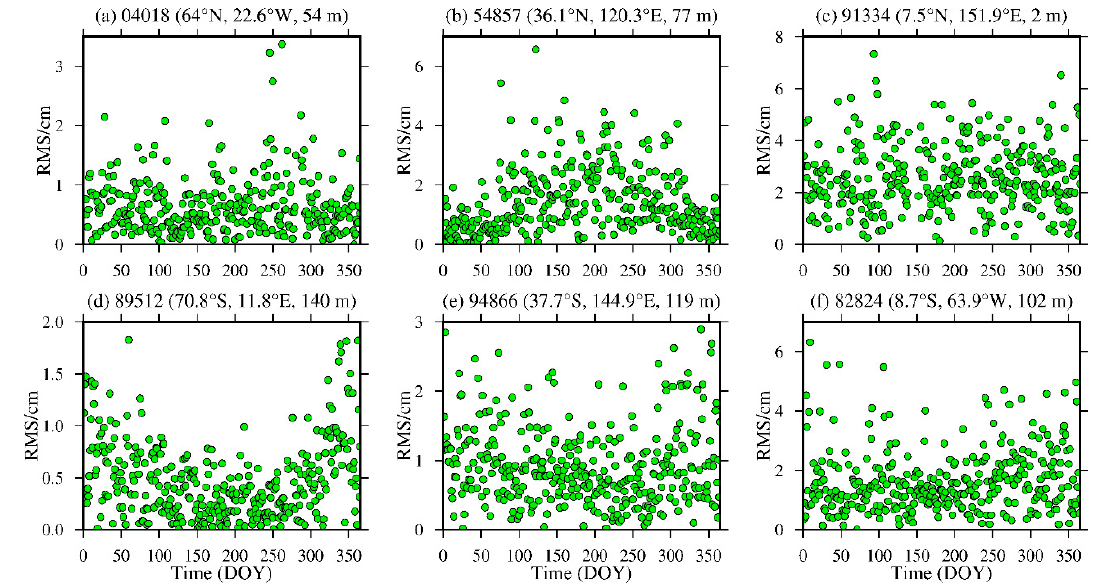
Figure 12. ZWD RMS time series of stations ( a ) 04018, ( b ) 54857, ( c ) 91334, ( d ) 89512, ( e ) 94866 and ( f ) 82824 derived from the MERRA-2 data from 2015 (the content in parentheses indicates the latitude, longitude and altitude of the radiosonde station).